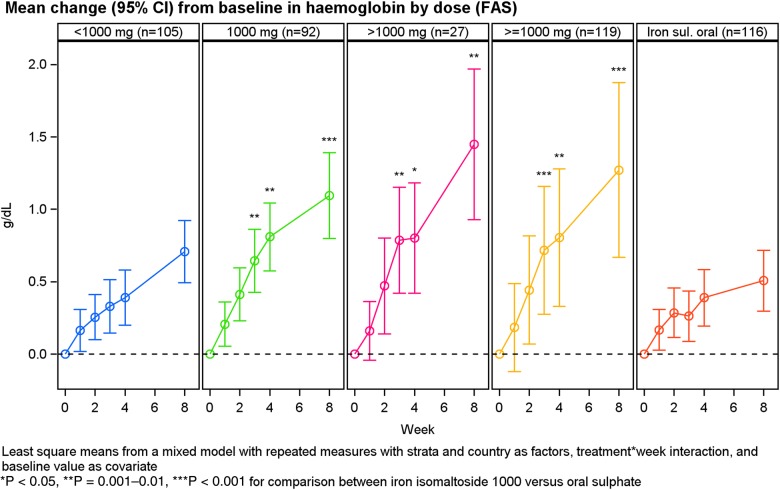
Hb over time by dose, mean (±SD) baseline Hb was 10.09 ± 1.03, 9.56 ± 0.92, 8.39 ± 1.13 and 9.64 ± 1.05 g/dL for patients treated with <1000 mg, 1000 mg, >1000 mg iron isomaltoside 1000 and oral iron sulphate, respectively.